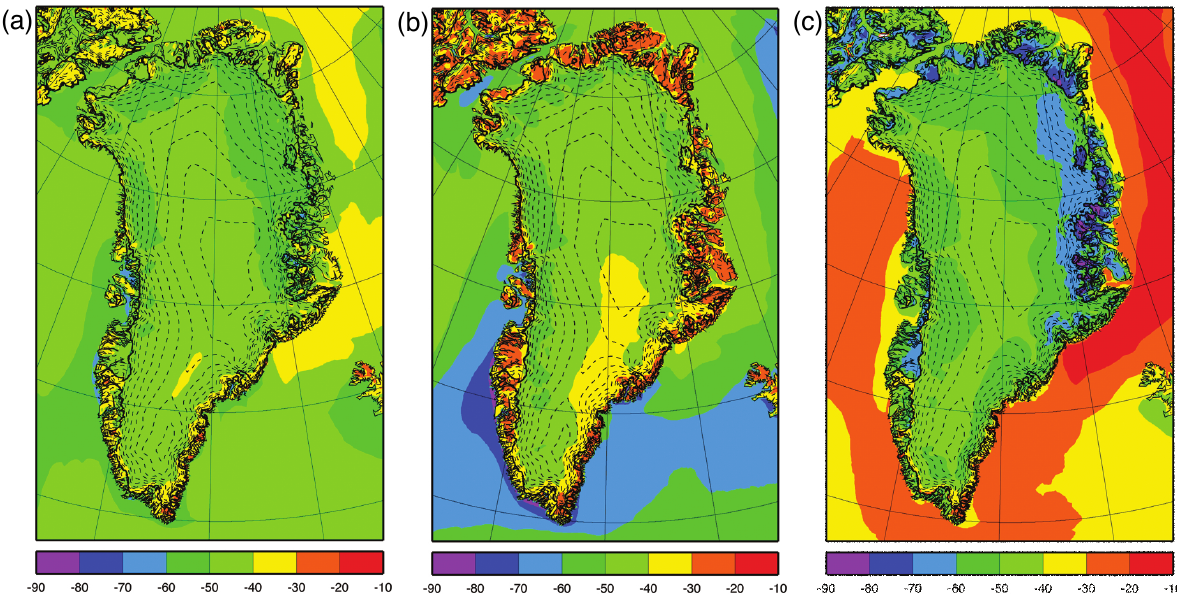
Fig. 10. Averaged net longwave radiation [Wm − 2 ] over (a) a year, and the seasons (b) DJF and (c) JJA.